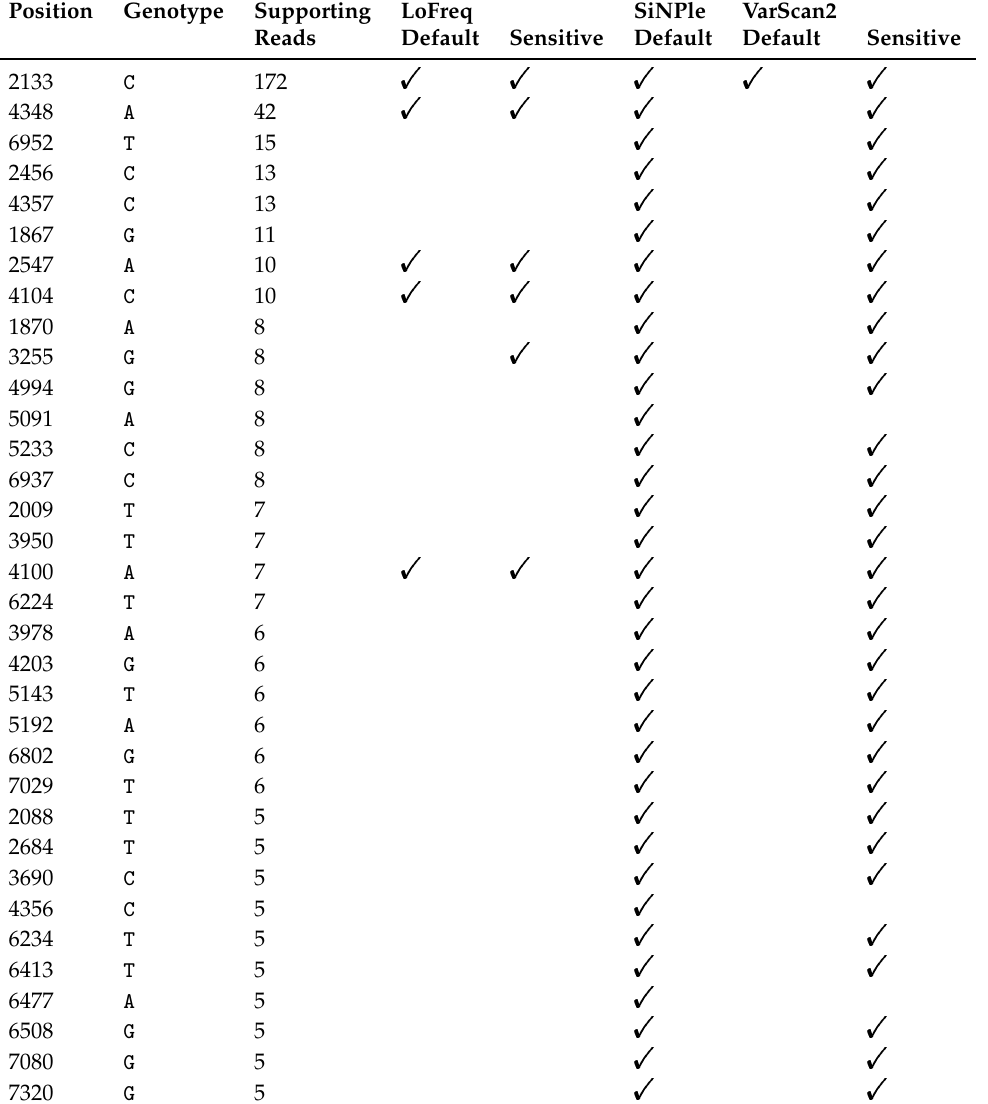
Table 2. Variants called by SiNPle, Lofreq and VarScan2 on 100,000 randomly sampled CirSeq reads. The table also shows the number of consensus reads from CirSeq that validate the second most frequent genotype. The variants in the table are the list of true positives thresholded at coverage 5 (see Section 2) and hence they are all likely to be real. We chose coverage 5 in order to obtain a table of reasonable size; other values produce similar results (see Figure